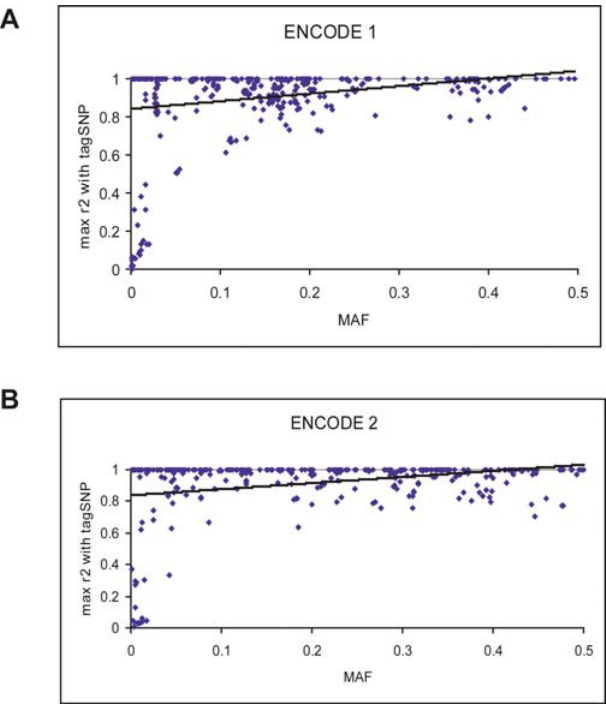
Figure 6. Maximum Distribution ( r 2 ) of SNPs from Estonia in Relation to CEU tSNPs Tags were selected from all polymorphic SNPs of the CEU population in (A) the ENCODE 1 region (138 tSNPs) and (B) the ENCODE 2 region (171 tSNPs). DOI: 10.1371/journal.pgen.0020027.g006